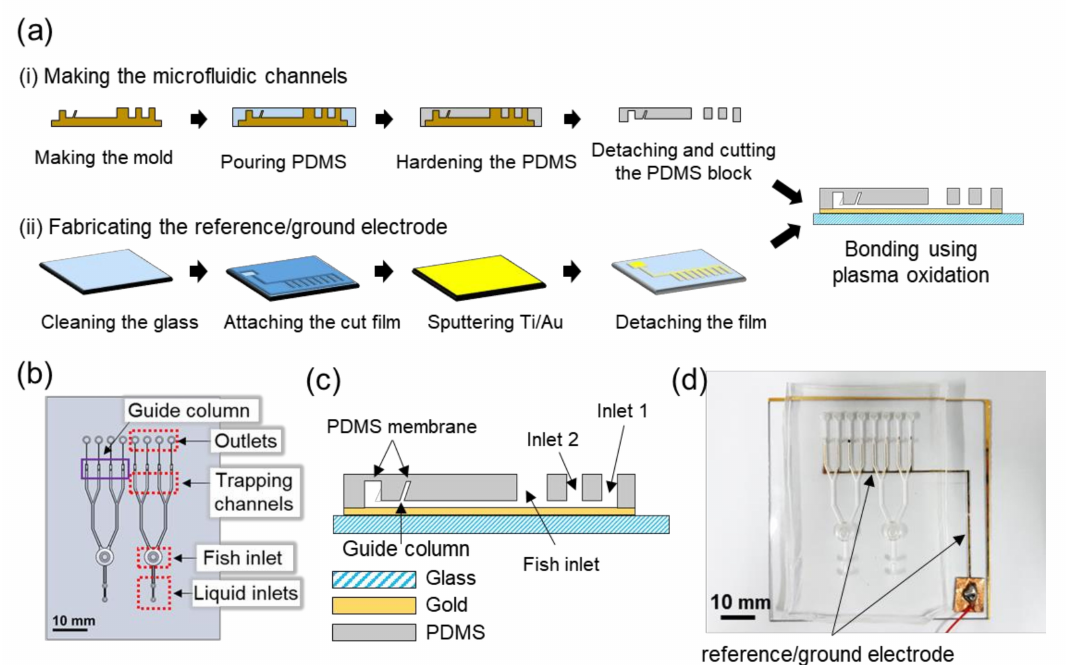
Figure 1. Design and fabrication of the microfluidic chip. ( a ) Fabrication process of (i) the microfluidic channels patterned in a PDMS block and (ii) the reference / ground electrode sputtered on a glass substrate. The structured PDMS block and the glass substrate were bonded together using plasma treatment. Schematics of the microfluidic chip containing microfluidic channels from ( b ) the top and ( c ) side views. ( d ) Photograph of the completed microfluidic chip containing gold patterns of reference / ground electrode at the bottom of the